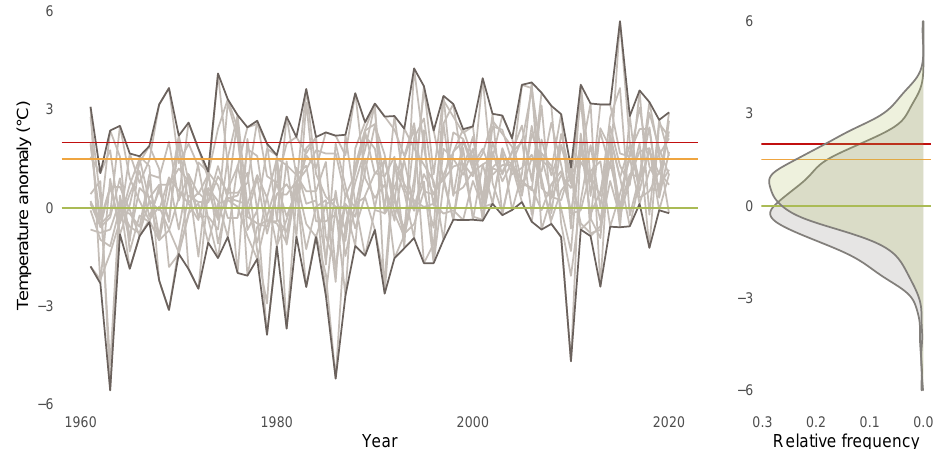
Figure 5. Anomalies for years 1961 until 2020 ( left display), where each line represents anomalies for one month. Right display shows empirical densities of anomalies for years 1850 until 1900 (grey) and 1961 until 2020 (green). Horizontal lines indicate anomalies of 0 ◦ C (green), 1.5 ◦ C (orange), and 2 ◦ C (red).